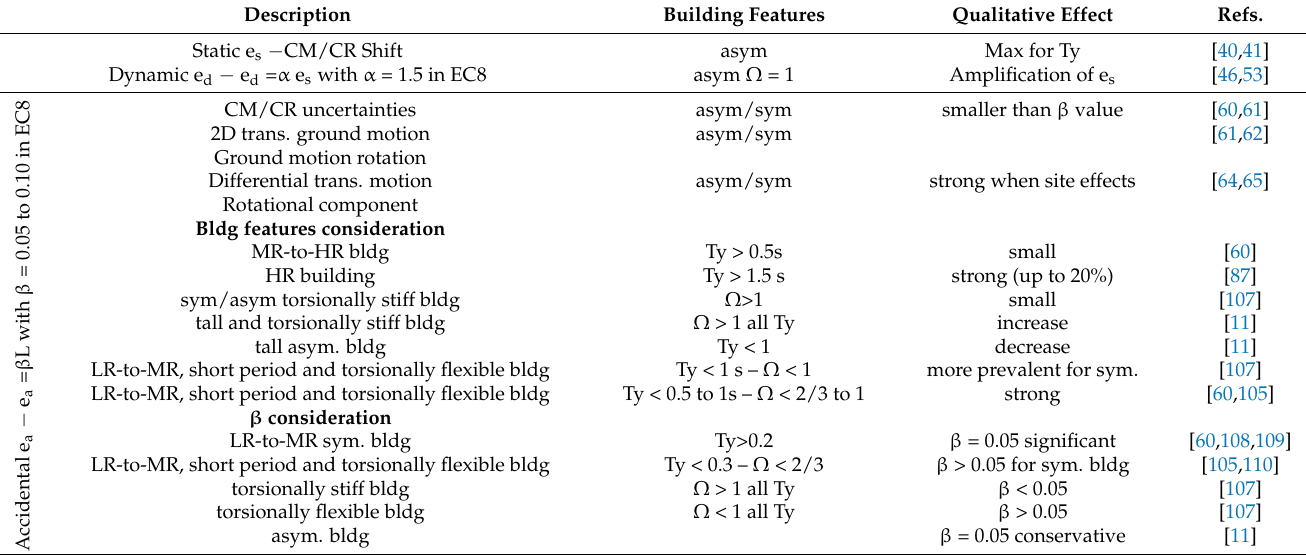
Table 1. Qualitative description of the torsion effects. LR, MR, HR: low-rise, mid-rise, high-rise building. CM: centre of mass. CR: centre of rigidity. e s : static eccentricity. e d : dynamic eccentricity. e a : accidental eccentricity. L: dimension perpendicular to the direction of the seismic motion. Ty: resonance period in translation. Ω : torsion-to-translation frequency ratio. Bldg: